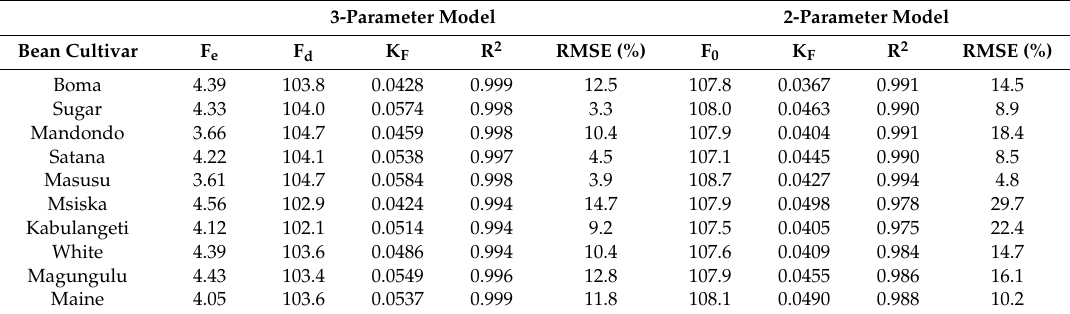
F e = equilibrium force during cooking; F d = di ff erential softening representing the total degree of softening over the cooking period; K F = rate constant of bean softening; F o = initial force prior to cooking. (Tukey–Kramer HSD ( α =